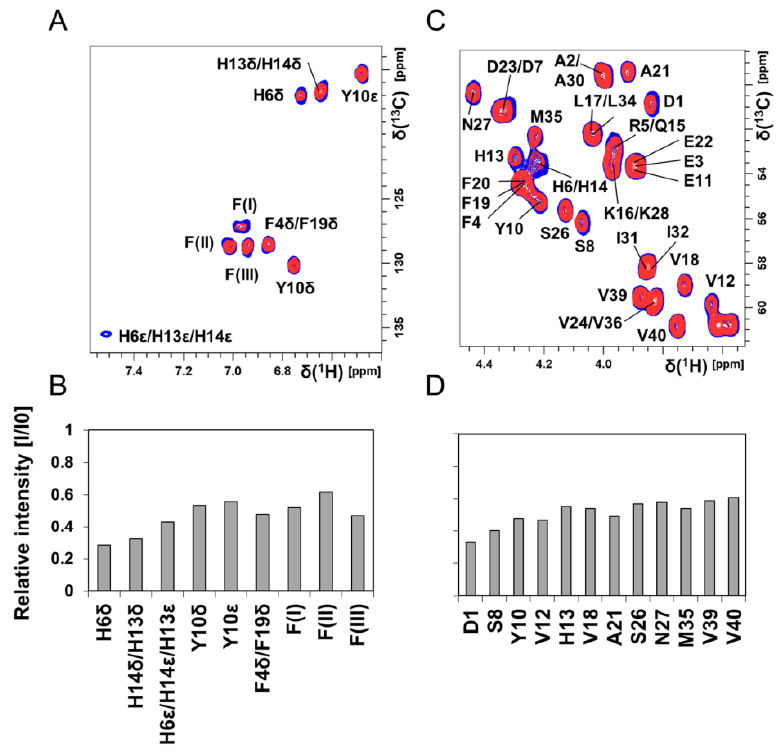
Figure 4. Two-dimensional (2D) NMR 1 H– 13 C-HSQC experiments showing Aβ 40 residue-specific perturbations from Hg(II) ions in buffer; 700 MHz NMR data of 84 µM monomeric 13 C- 15 N-labeled Aβ 40 peptides in 20 mM sodium phosphate buffer pH 7.35 at +5 °C are shown in ( A – D ). ( A ) 1 H– 13 C-HSQC spectra showing the aromatic region of Aβ peptides (blue) and with 80 µM Hg(II) ions (red). In ( B ), the relative intensities from the spectra in ( A ) are shown. Crosspeaks marked with F(I)–F(III) are resonances from phenylalanine residues, without any detailed assignment. ( C ) 1 H– 13 C-HSQC spectra showing the C α –H region of Aβ peptides (blue) and with 80 µM Hg(II) ions (red). In ( D ), the relative intensities from the spectra in ( C ) are shown. Significant chemical shift changes were not observed. In ( D ), only crosspeaks without any spectral overlap were included in the evaluation.